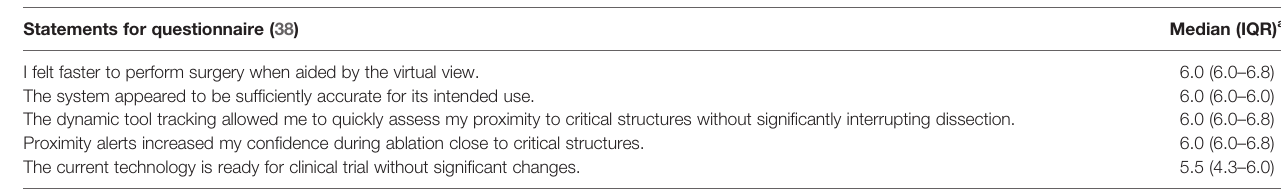
TABLE 1 | Questionnaire answers and surgeons ’